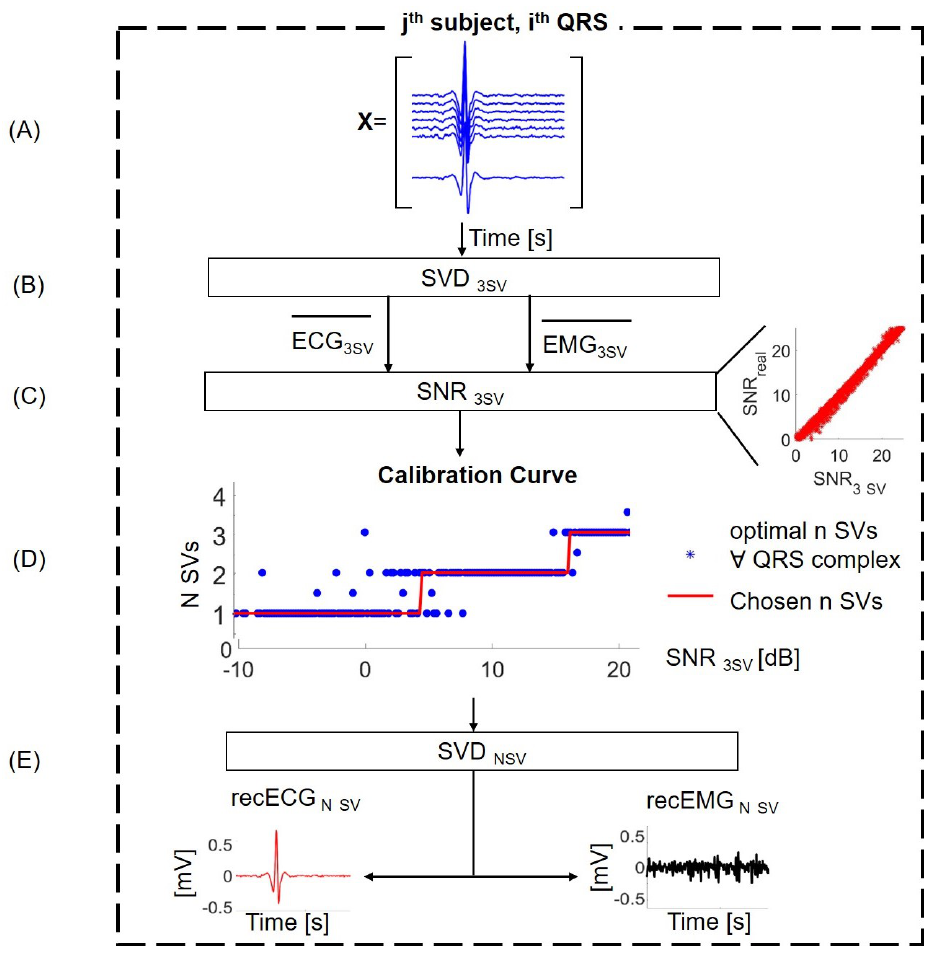
Figure 3. The choice of the optimal number of SVs. ( A ) Synthetic dataset with EMG + ECG signals around a single QRS complex; ( B ) application of the algorithm described in the previous section selecting three SVs to obtain an estimation of the EMG and ECG components; ( C ) SNR estimation considering ECG 3SV and EMG 3SV ; this approximation stands since there is a linear relationship between the real SNR and the estimated SNR with ECG 3SV and EMG 3SV shown in the figure (Panel C—on the right); ( D ) calibration curve: the choice of the optimal number of SVs on the basis of the approximation to step functions; ( E ) application of the algorithm with the appropriate number of